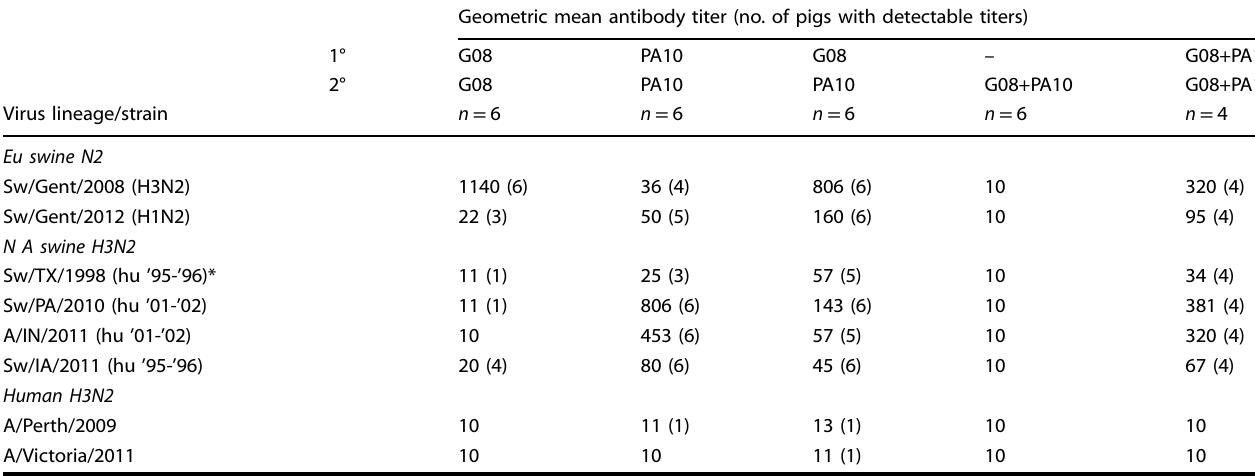
Table 3. Comparison of NI antibody titers against heterologous H3N2 and H1N2 in fl uenza viruses in pigs of different vaccine groups Geometric mean antibody titer (no. of pigs with detectable